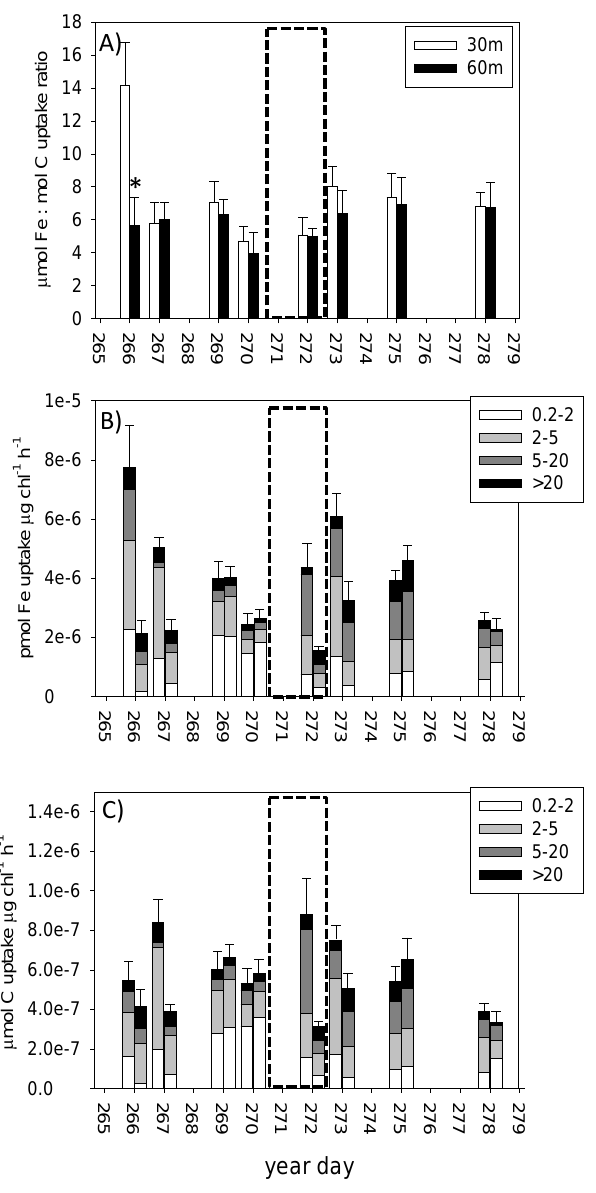
Fig. 2. Radioisotope-based Fe:C uptake ratios and chl-normalized molar Fe and C uptake rates from samples collected at 30 and 60m over the course of the study based on 24h 55 Fe and 14 C incu- bations. (A) Total µmolFe:molC uptake ratios calculated using Fe and C radiotracer uptake; (B) total chl-normalized Fe uptake (pmolFeµgchl − 1 h − 1 ) and stacked by size fraction, and (C) To- tal chl-normalized C uptake (µmolCµgchl − 1 h − 1 ) and stacked by size fraction. Stacked data represent (top to bottom) the > 20µm, 5–20µm, 2–5µm, and 0.2–2µm fractions. For each day, left bar=30m, right bar=60m. The transition between the two phases of the study is marked by the dashed line rectangle. Error bars repre- sent 1 standard deviation ( n = 3) for total values. Significant differ- ences between 30 and 60m total values are designated by an asterisk ( p < 0 .